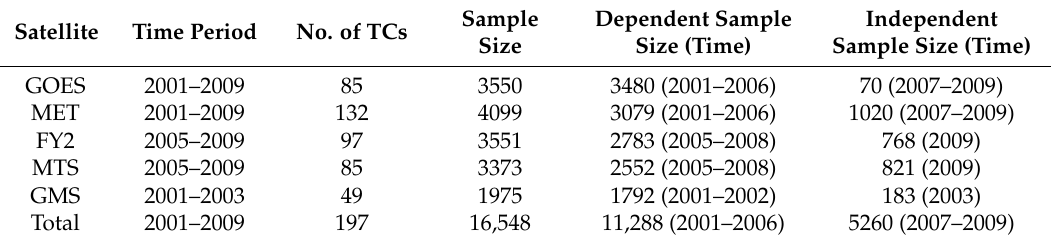
Table 1. Satellite data used to establish and test the model for the estimation of the size of